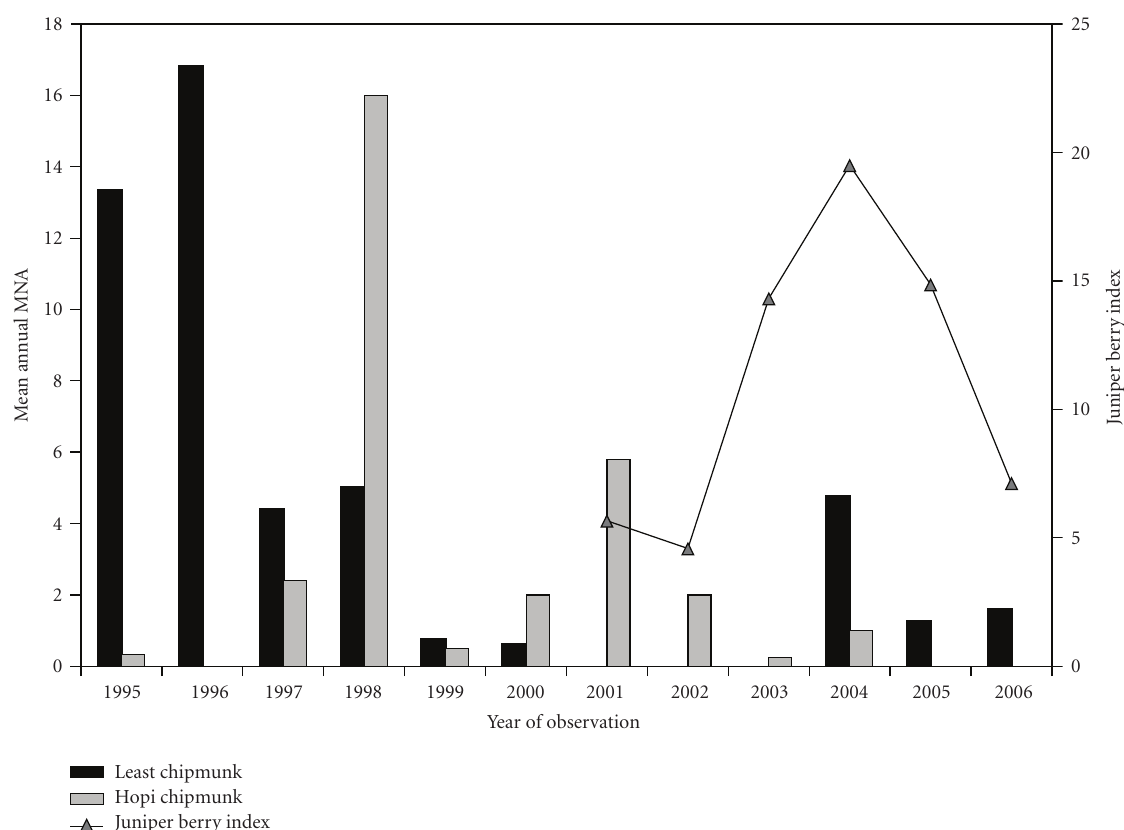
Figure 2: Annual juniper berry production and mean annual minimum number alive (MNA) of chipmunks at Molina,